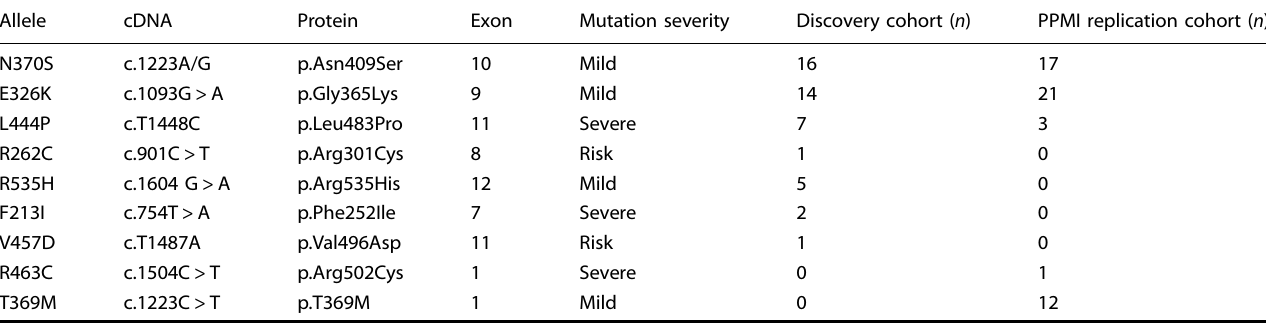
Table 4. List of GBA pathogenic variants considered for the inclusion of patients in the GBA -associated Parkinson ’ s disease group.